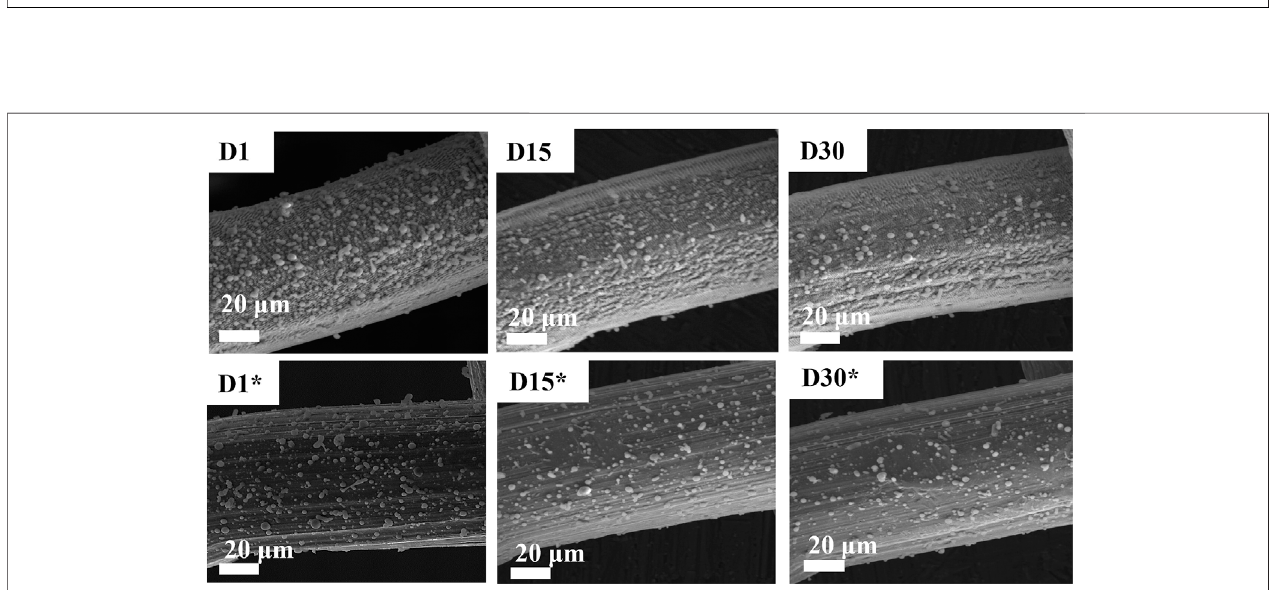
FIGURE 4 | Scanning electron microscopy (SEM) analysis of aging sodium zeolite-coated SS mesh. D1, D15, and D30 represent days, while * represents the unstructured surface.